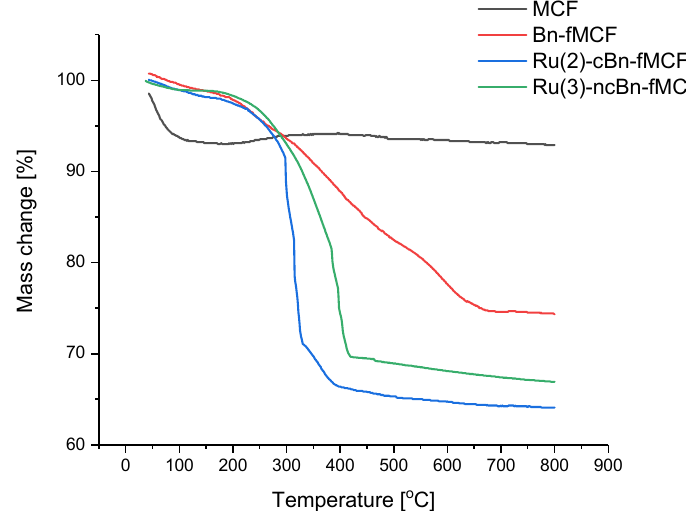
Figure 5. Thermogravimetry analysis (TGA) of MCF’s compounds.